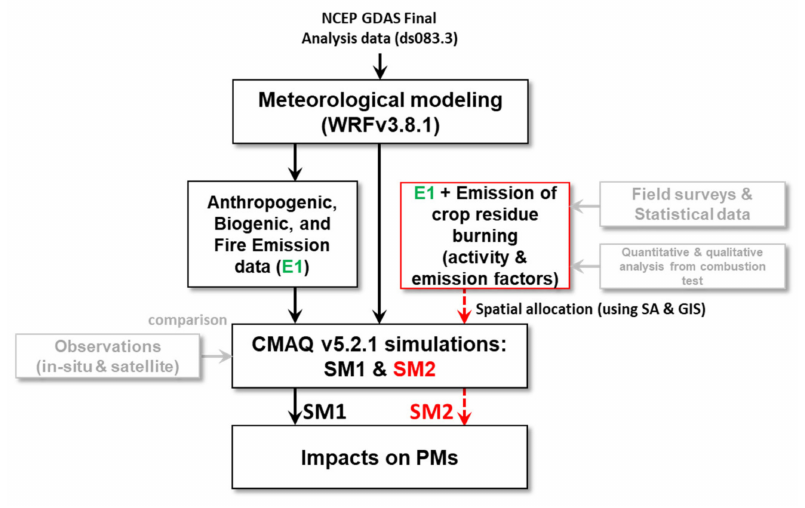
Figure 2. Process flow diagram for the